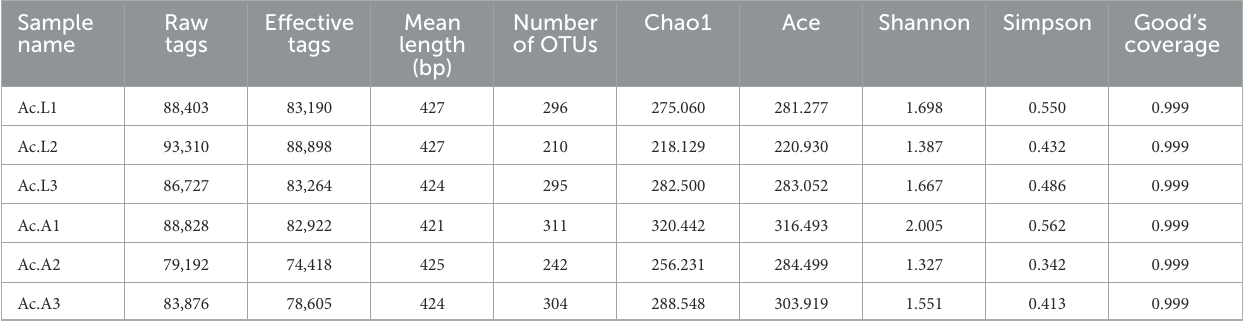
TABLE 2 Summary of 16S rRNA gene sequencing data.